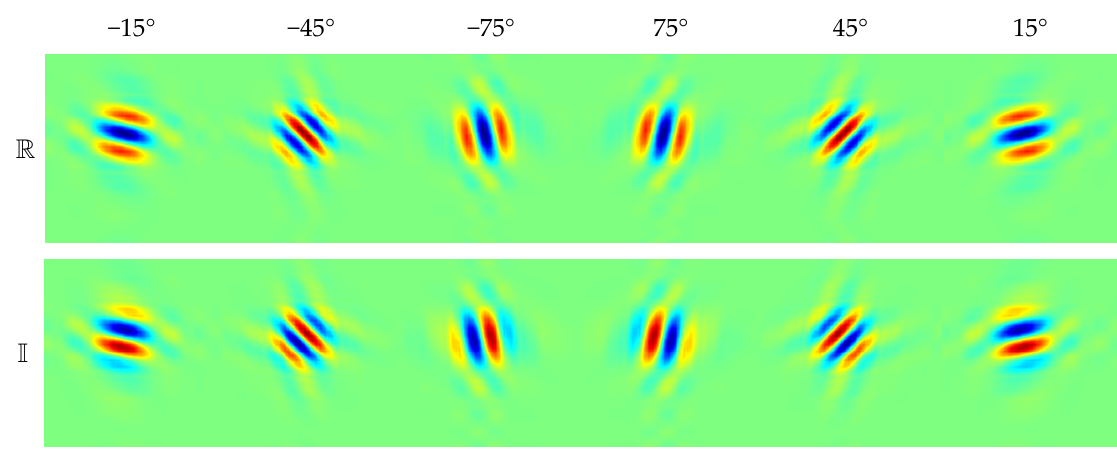
Figure 4. Directional Selectivity of dual-tree complex wavelet transform (DTCWT). ( R = Real, I = Imaginary).